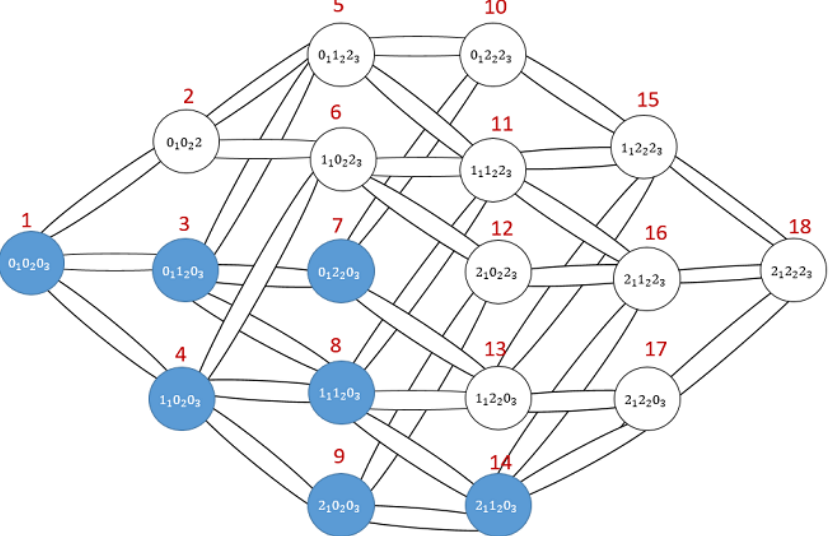
Figure 6. Case study1: Markov chain for 18